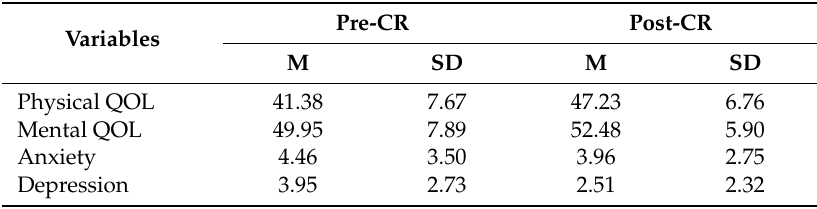
Table 1. Means and Standard Deviations of Physical and Mental Quality of Life [QOL], Anxiety, and Depression Scores Pre- and Post-Cardiac Rehabilitation